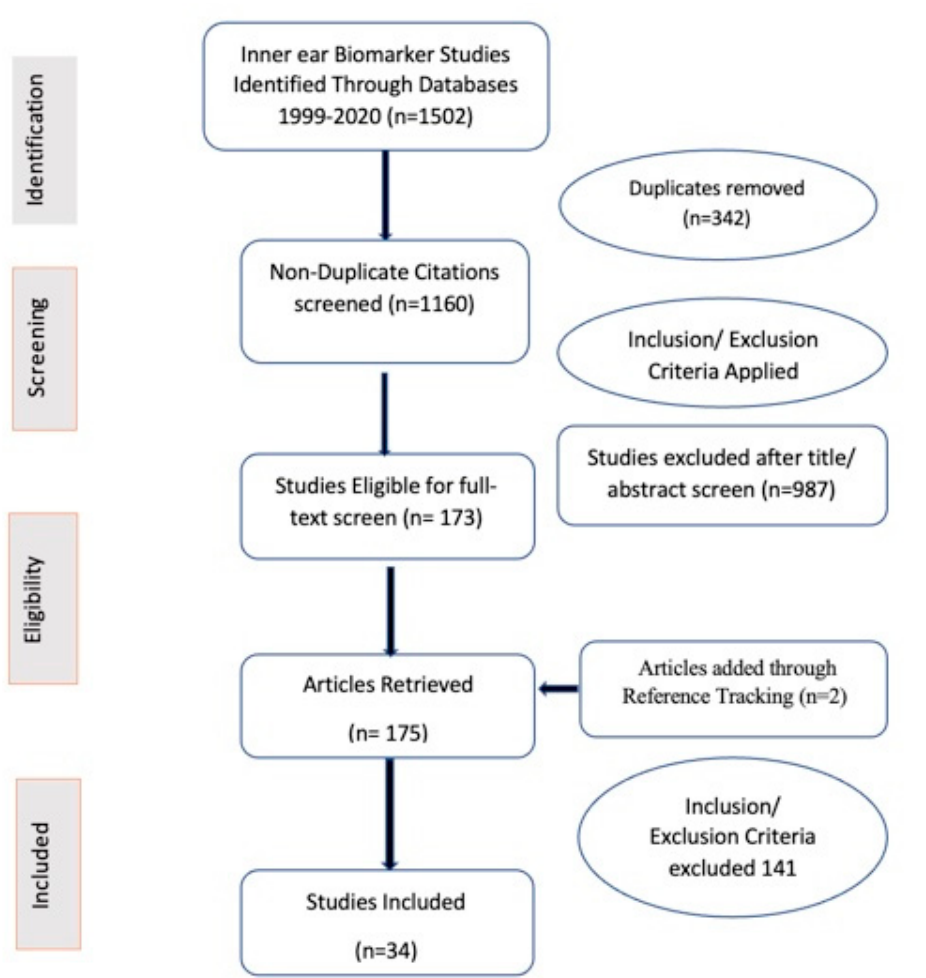
Figure 1. PRISMA (Preferred Reporting Items for Systematic Reviews and Meta-Analyses) diagram for article selection.